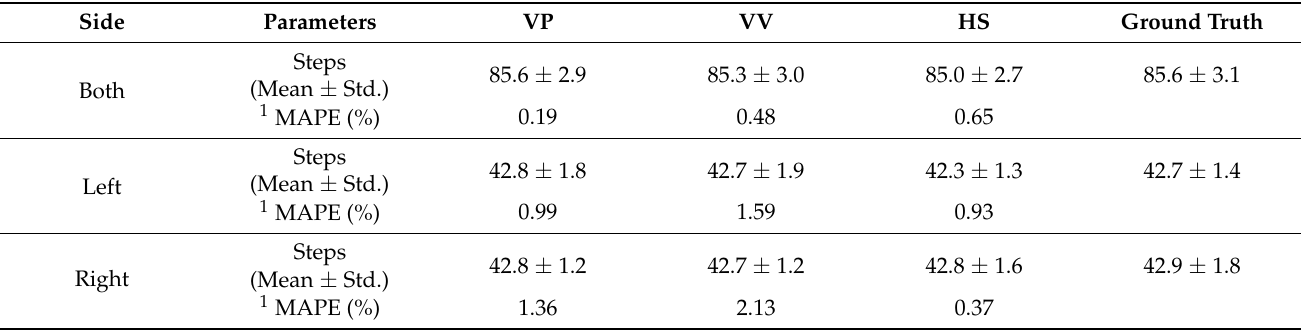
Table 1. Comparison of step counting with four